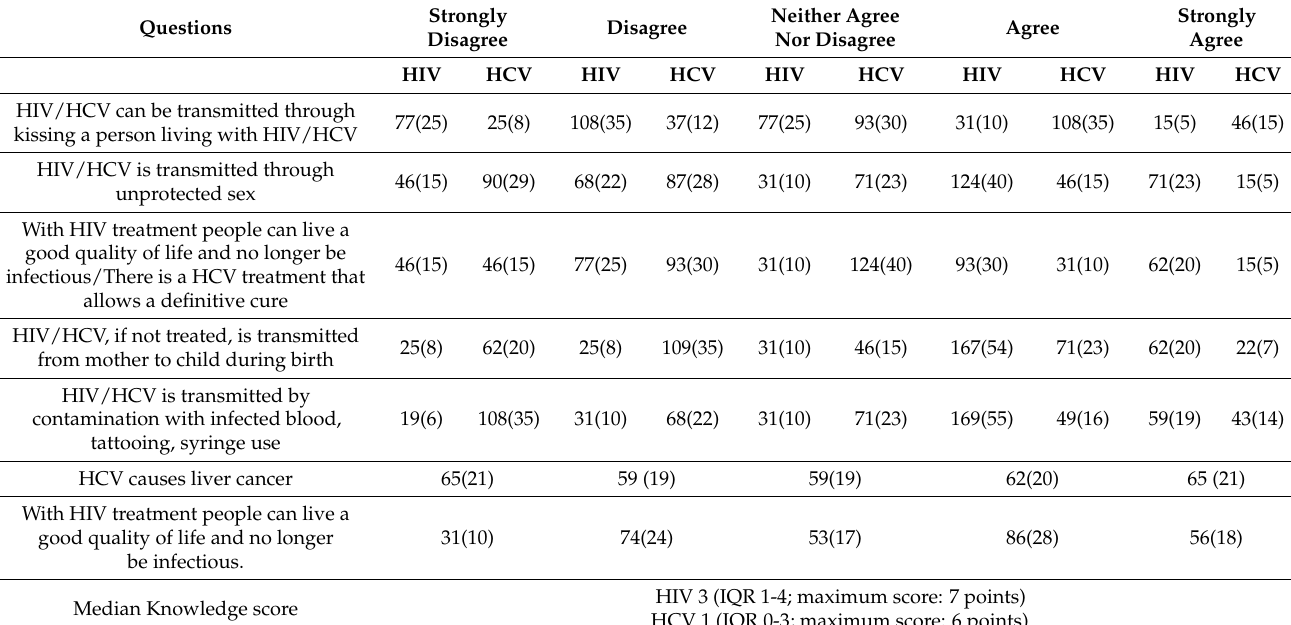
Table 2. HIV-HCV